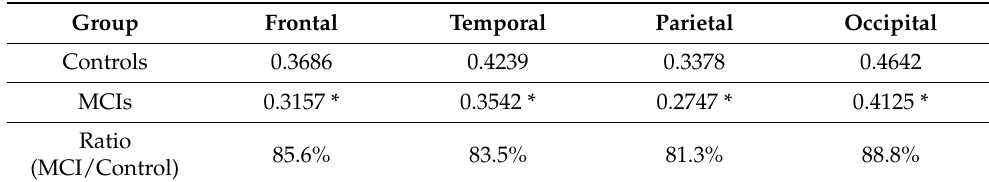
Table 7. The intra-lobular connectivity and connectivity ratios (MCI/controls) of four cerebral lobes for the control and MCI groups. * p < 0.05.